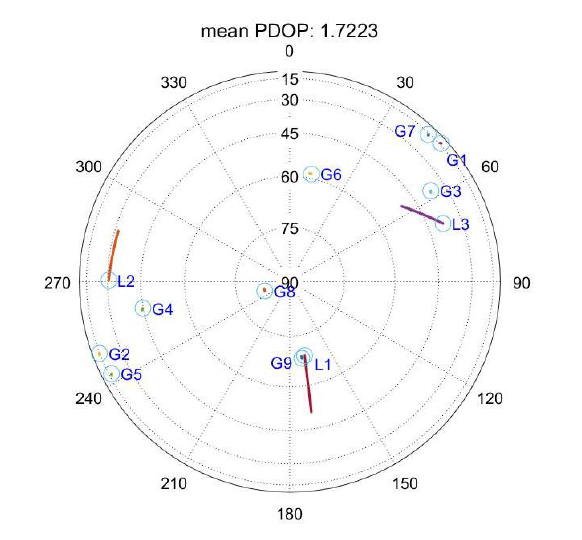
Figure 3. Sky-plot of the Simulated GPS/LEO satellites